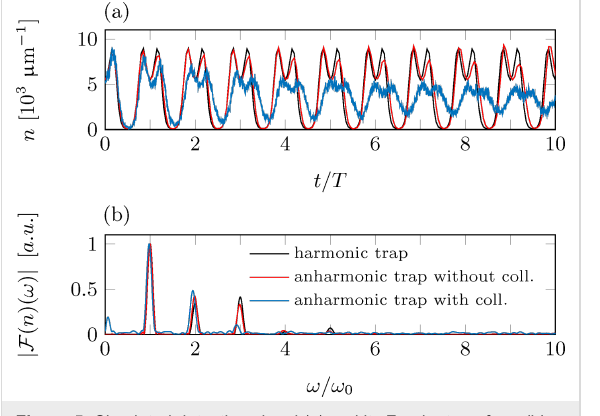
Figure 5: Simulated detection signal (a) and its Fourier transform (b) for a detector based on local density probing, as derived from a numer- ical simulation ( N = 5 × 10 5 , T = 500 nK). The tip oscillates in a harmonic/anharmonic trap (black lines/colored lines) with ω 0 = 2 π × 50 Hz and ε = 2 × 10 8 m − 1 s − 2 . Particle collisions are taken into account (blue lines) or neglected (red lines). The oscillation ampli- tude and the outcoupling position have been fixed to A = 2 σ x and x 0 = σ x .